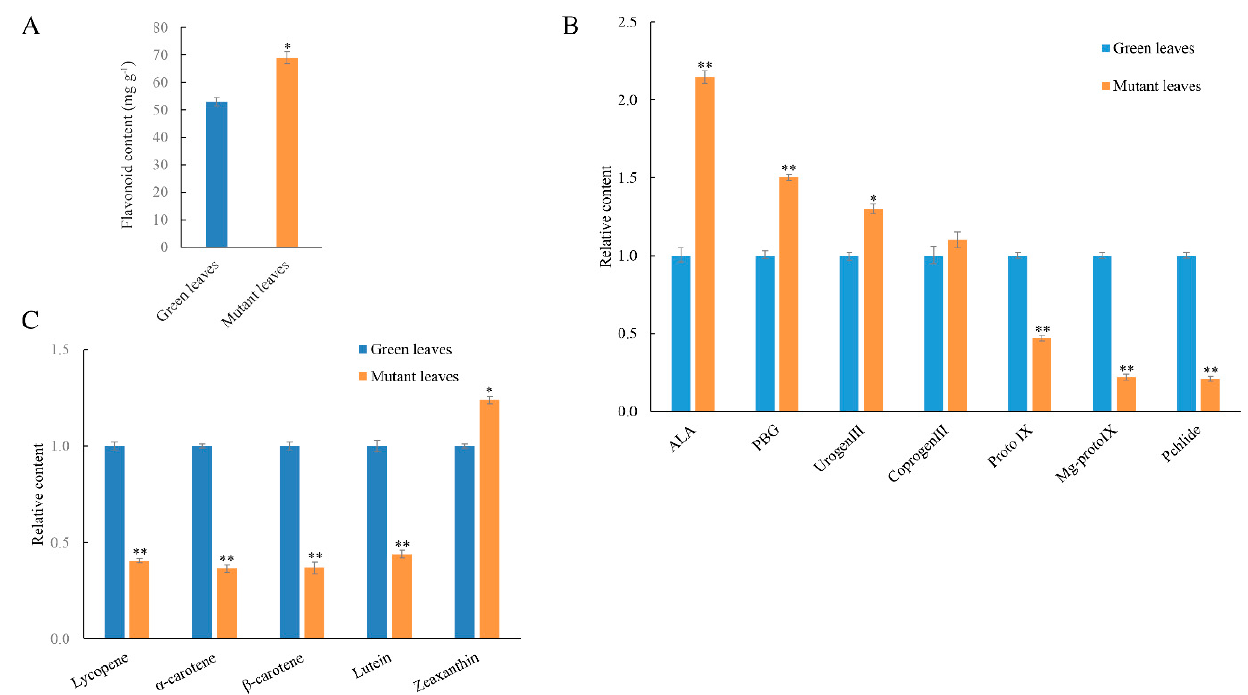
Figure 2. Pigment contents in leaves of hybrid paper mulberry. ( A ) Total content of flavonoids in green and mutant leaves. ( B ) Analysis of relative chlorophyll intermediary contents in green and mutant leaves. ( C ) Relative carotenoid component contents in green and mutant leaves. Error bars indicate mean ± SD, from three independent replicates. Student’s t -test was used to identify significant differences in mutant and green leaves (* p < 0.05, ** p < 0.01). ALA, 5-aminolevulinic acid; PBG, porphobilinogen; Urogen III, uroporphyrinogen III; Coprogen III, coproporphyrinogen III; Proto IX, protoporphyrin IX; Mg-Proto IX, Mg-protoporphyrin IX; Pchlide, protochlorophyllide.